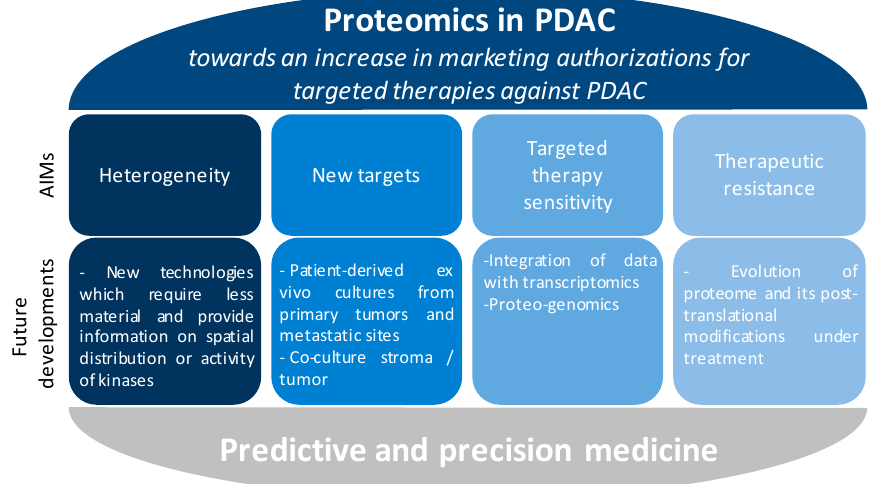
Figure 1. Using proteomics to improve the clinical care of patients with pancreatic cancer.